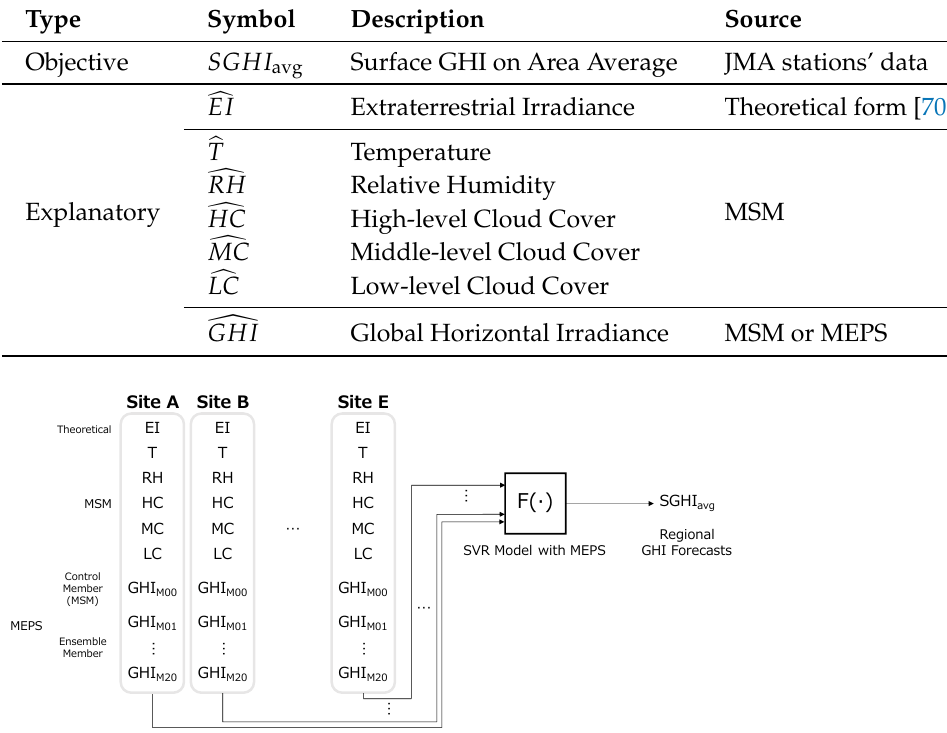
Figure 8. Configuration of SVR models with MEPS forecasts.